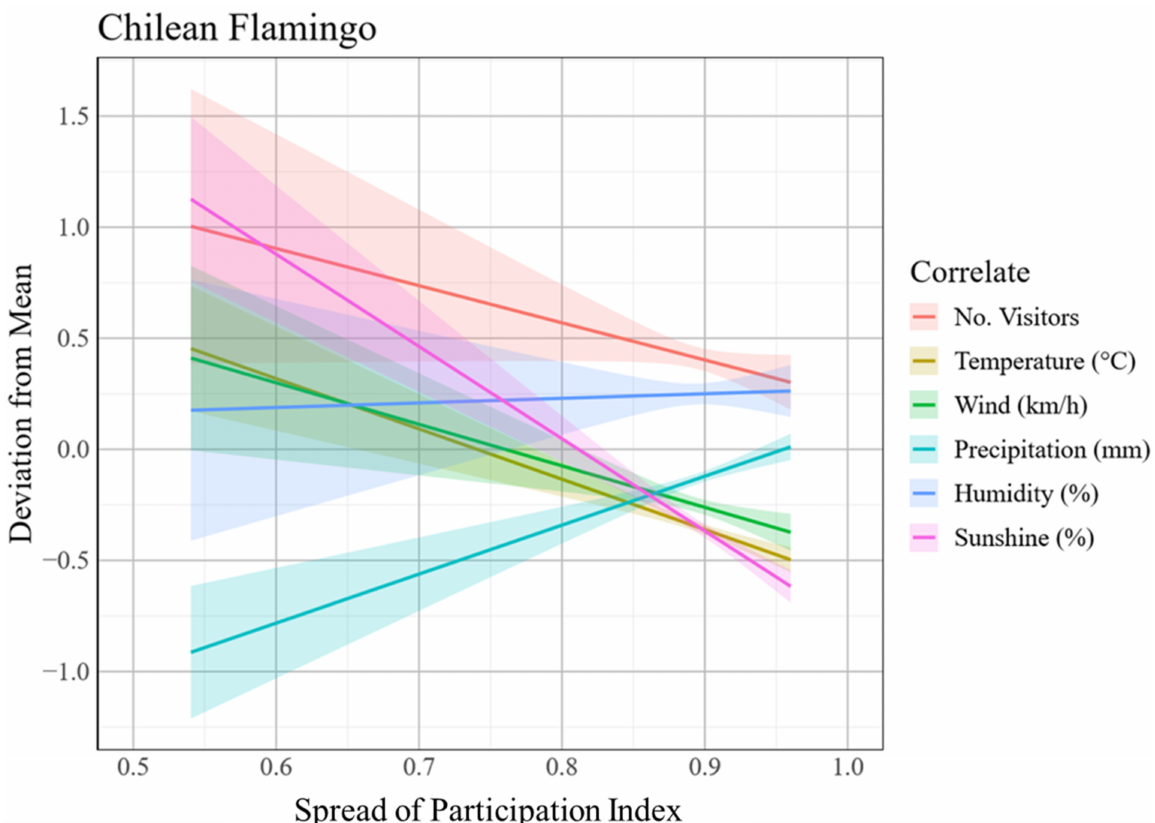
Figure 9. Correlation between Spread of Participation Indices (SPIs) of Chilean Flamingos during the zoo open condition and visitor and environmental variables. Correlates were centred around the mean. Intercept = mean. Shaded areas around lines represent ± 95% CI. An increase in visitor numbers, temperature, wind, and sunshine were associated with less widespread use of the enclosure. An increase in precipitation and humidity were associated with a wider use of zones.